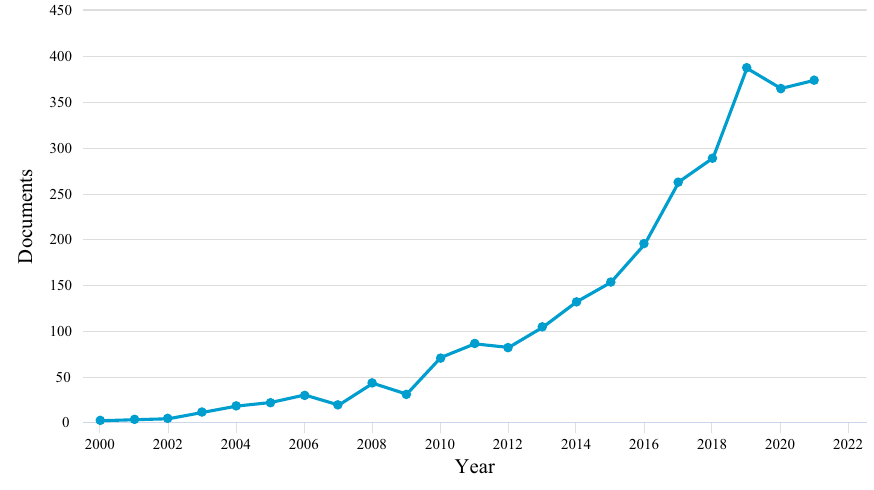
Fig. 1 The number of publication on cybersecurity since 2000